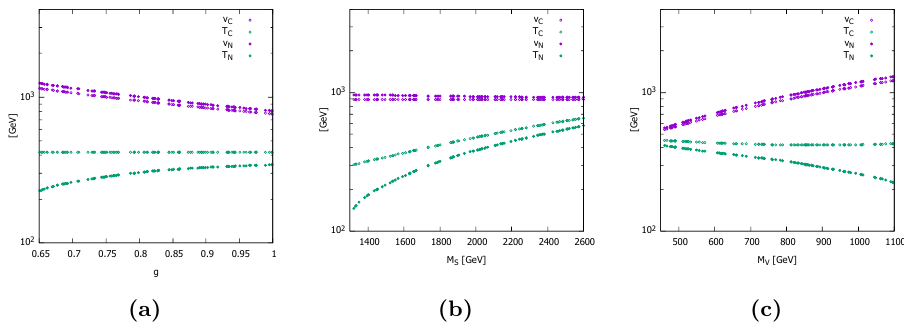
Figure 6. Variation of ν C and T C ( ν N and T N ) respect to parameter space. In all digrams the fixed parameters are: M = 1800 GeV , M = 800 GeV , g = 0 . 85 S V